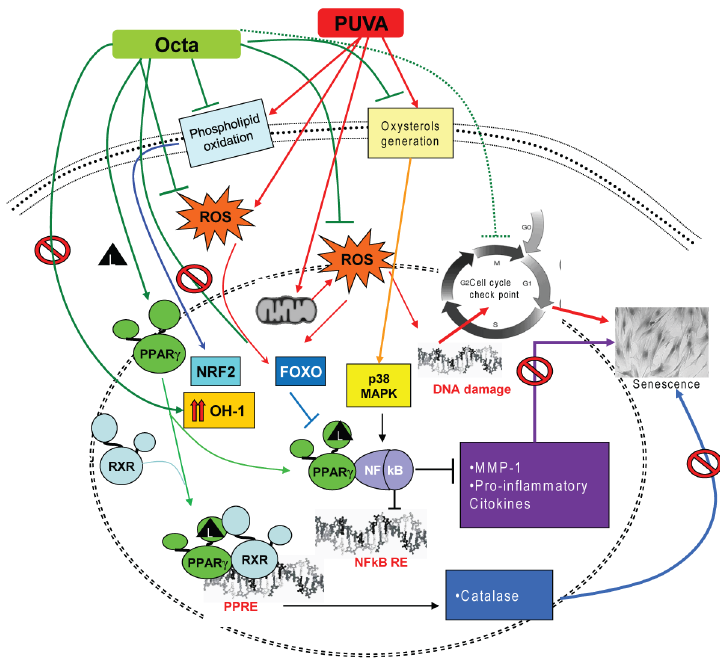
Figure 10. Summary scheme of possible role of PPAR c modulation in counteracting PUVA-SIPS of HDFs. PUVA exposure induced intracellular generation of ROS, alteration of mitochondria function, activation of antioxidant stress response and MAPK phosphorylation pathway, dysregulation of membrane lipid metabolism, DNA-oxidative damage and altered expression of cell cycle regulators. PPAR c modulation by Octa may counteract PUVA-induced senescence-like phenotype. Moreover, Octa ability to reduce phospholipid oxidation and oxysterol generation contributes to the reduction of PUVA-induced inflammatory response and redox imbalance.